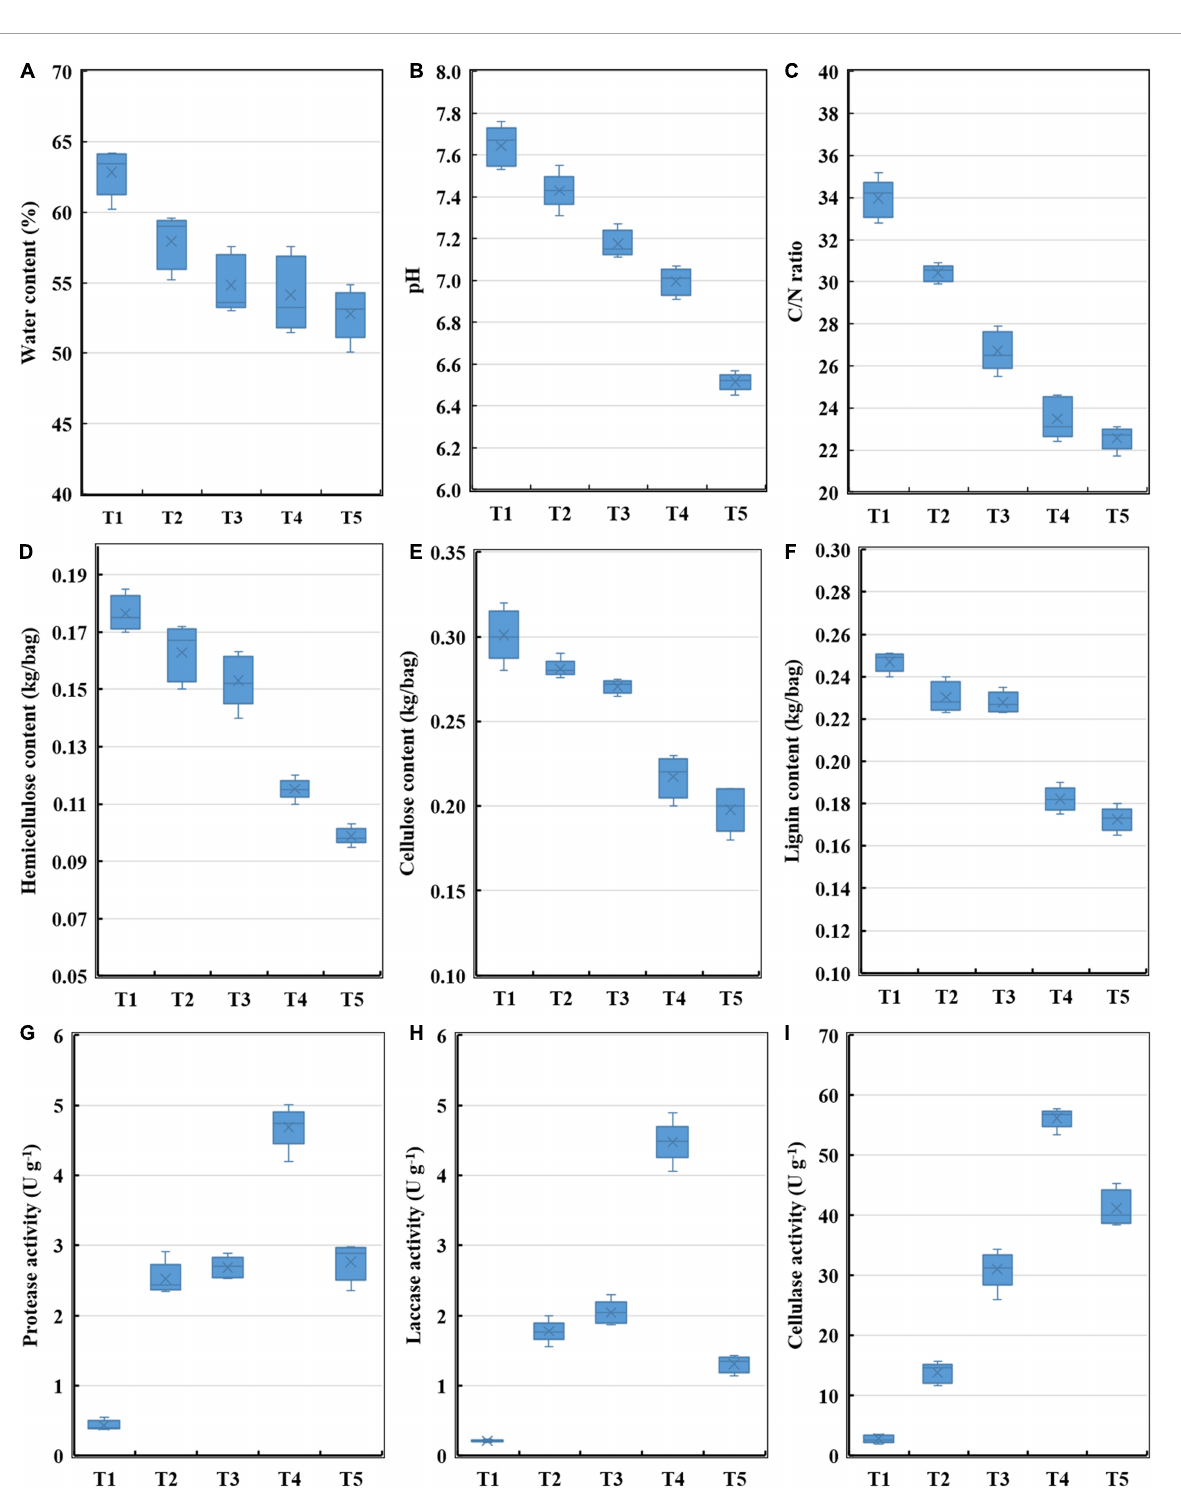
FIGURE1 Enzyme activities and physicochemical properties of composting substrate at the different growth stages of oyster mushroom. (A) Water content; (B) pH; (C) C/N ratio; (D) hemicellulose content; (E) cellulose content; (F) lignin content; (G) protease activity; (H) laccase activity; and (I) cellulase activity. T1, T2, T3, T4, and T5 indicate the day on which composting was completed (day 0: before spawning), mycelial colonization (day 3), mid-incubation (day 10), end-incubation (day 20: before primordia formation), and first oyster mushroom fructification (day 30: fruiting body development),